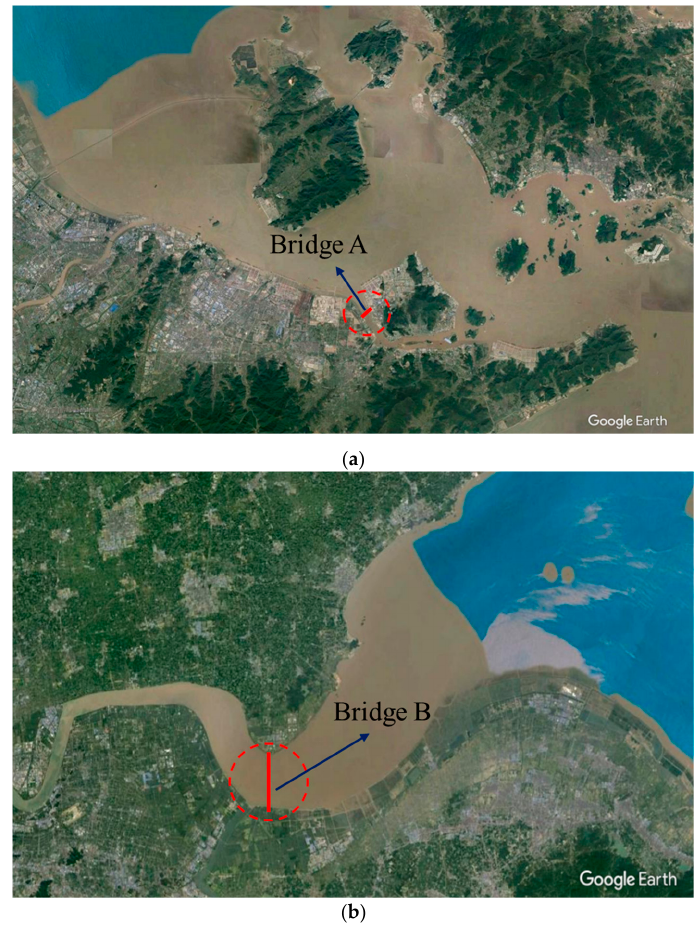
Figure 4. Locations of the investigated Bridge A and Bridge B: ( a ) Bridge A; ( b ) Bridge B.